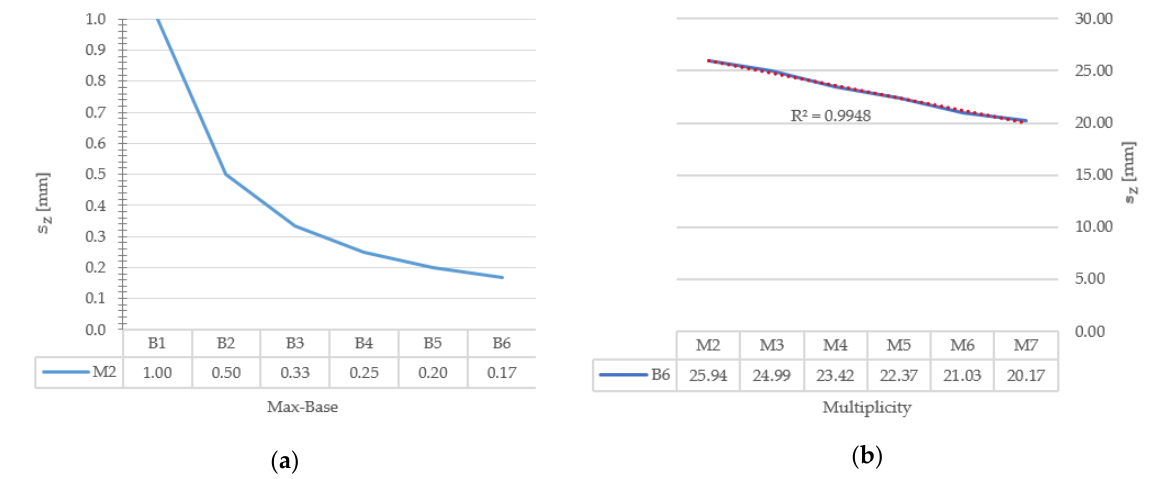
Figure 2. Graphs showing the theoretical performance of precision σ Z as a function ( a ) of the max- base at M2 (data are plotted to show the influence of max-base variability and are computed applying equation 1) and ( b ) of the multiplicity at B6 (data are plotted to show the influence of multiplicity variability and are simulated using a least ‐ squares system).